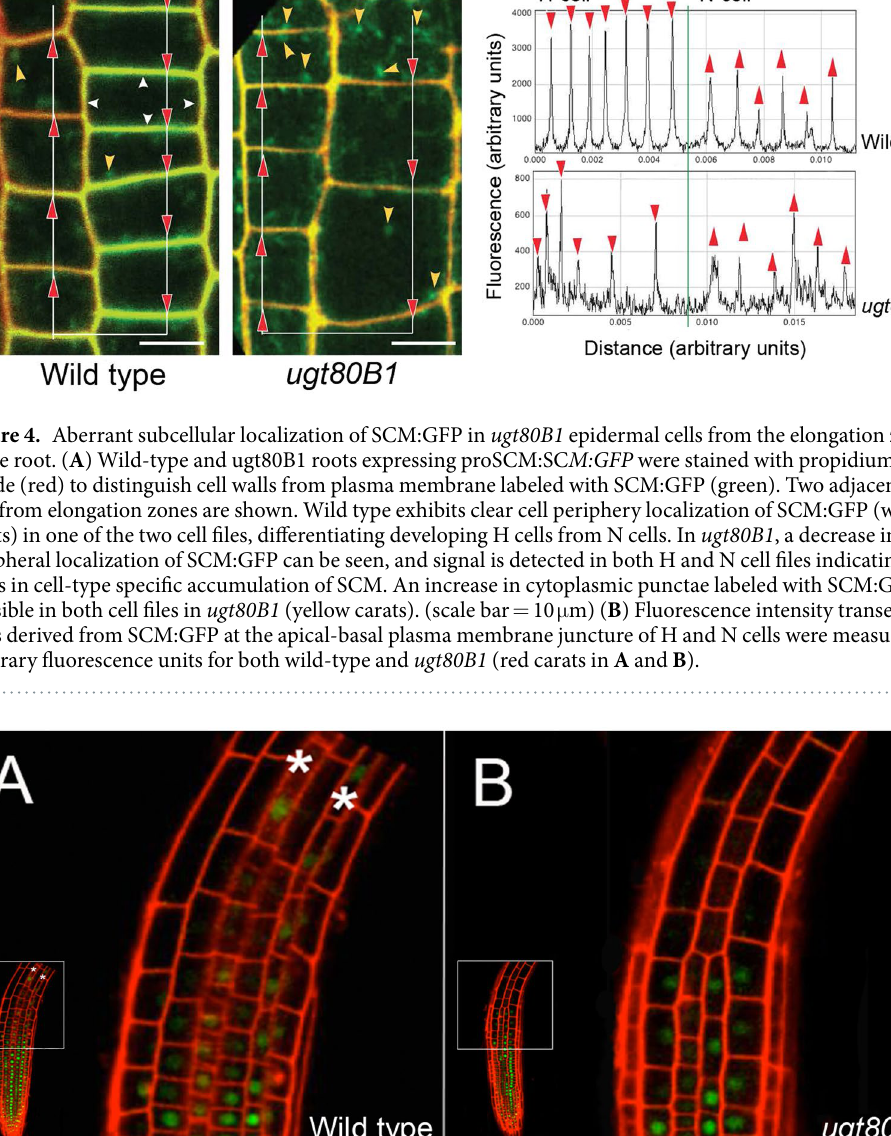
lower emission than plants expressing pro35S:UGT80B1:GFP . We therefore proceeded to use the pro35S:UGT- 80B1:GFP lines for further live imaging studies. As suggested from previous reports 31–33 , UDP-Glc:sterol glucosyltransferase was hypothesized to be localized in the ER (endomembrane) and possibly also in the plasma membrane (PM). To test this hypothesis, we visual- ized UGT80B1:GFP in the subcortical focal plane and could observe features that appeared reminiscent of the highly dynamic cisternae of the ER (Movie S3). We identified the fluorescent bodipy dye ER Tracker (587 excita- tion nm, 615 nm emission) as a vehicle to test whether fluorescence from UGT80B1:GFP pixels colocalized with pixels from the ER dye and results supported colocalization of the UGT80B1:GFP (Supplementary Figure S3) and the positive control ER reporter Q4:GFP line 34 . Using the same experimental rationale, we employed the membrane reporter FM4–64 (515 nm excitation, 640 nm emission maxima) to visualize colocalization at the PM after short term (5 min) exposure using PLASMAMEMBRANE INTRINSIC PROTEIN2 (PIP2):GFP as positive control, which also revealed satisfactory colocalization (Supplementary Figure S4) to support previous biochem- ical reports 31–33 .